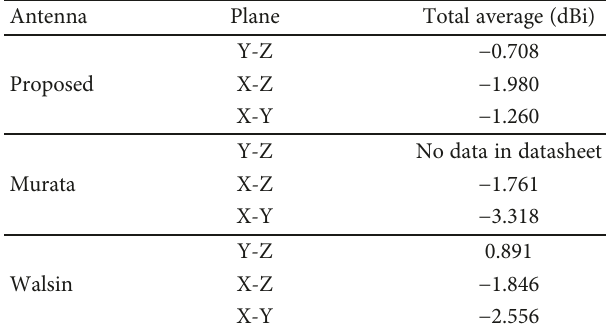
Table 4: Gain between proposed PIFA, Murata [13], and Walsin monopole antennas